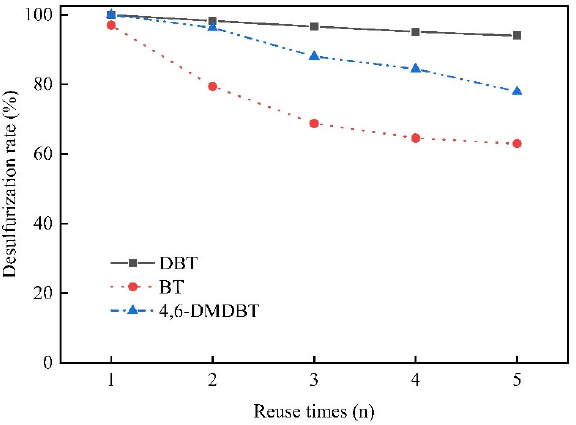
Figure 10. Effect of reuse times on the oxidative desulfurization rate of DBT, BT, and 4,6 ‐ DMDBT.